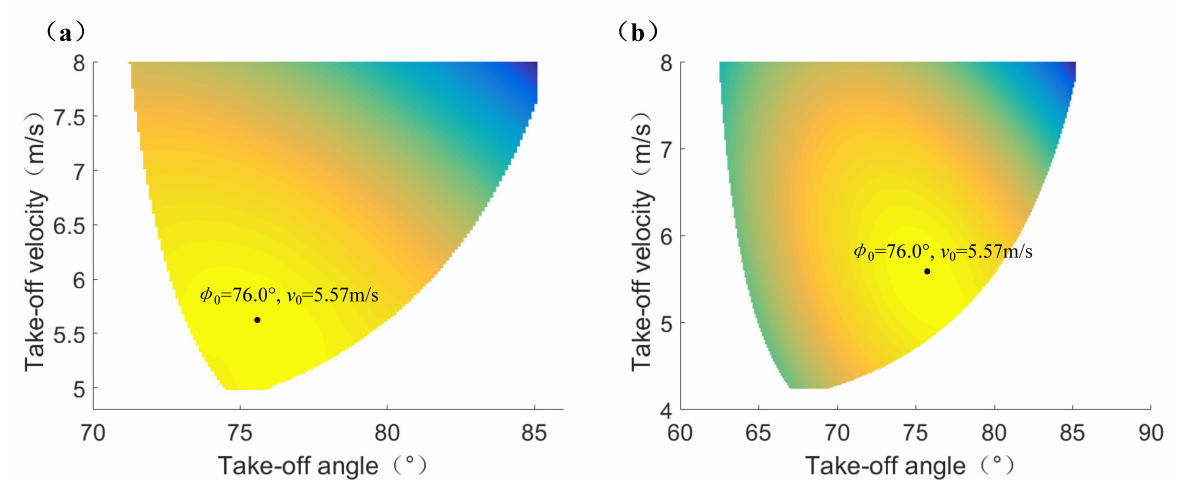
Figure 8. The optimization results of theoretical jumping trajectory. ( a ) The optimum take-off parameters for jumping onto the platform. ( b ) The optimum take-off parameters for jumping over the